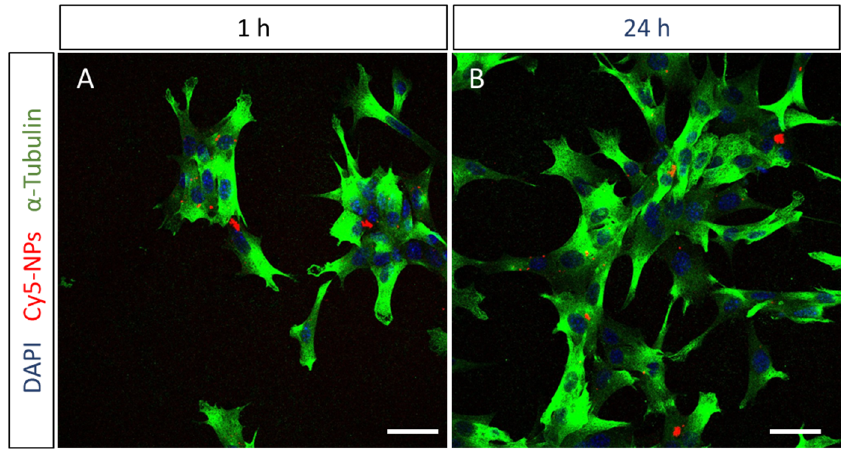
Figure 4. In vitro uptake study. Confocal images of 661W-A11 photoreceptor cells ( A ) 1 h and ( B ) 24 h after administration of HA12-coated NPs. Red: Cy5-labeled NPs; Blue: DAPI labelling nuclei; Green: α -Tubulin labelling the cytoskeleton. Scale bar 40 µm.